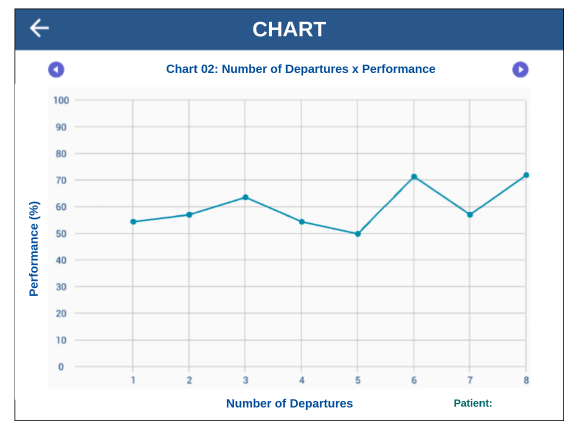
Figure 11. Scene of the performance coefficient graph generation. Source: Author